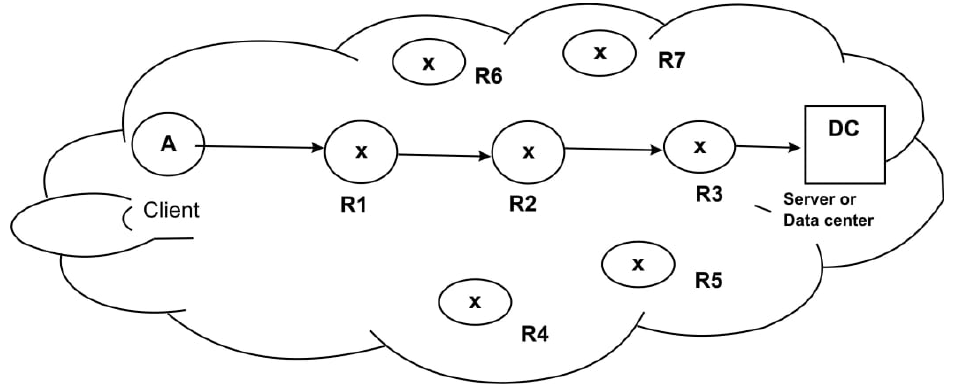
Figure 1. Client (A) communicating with data center